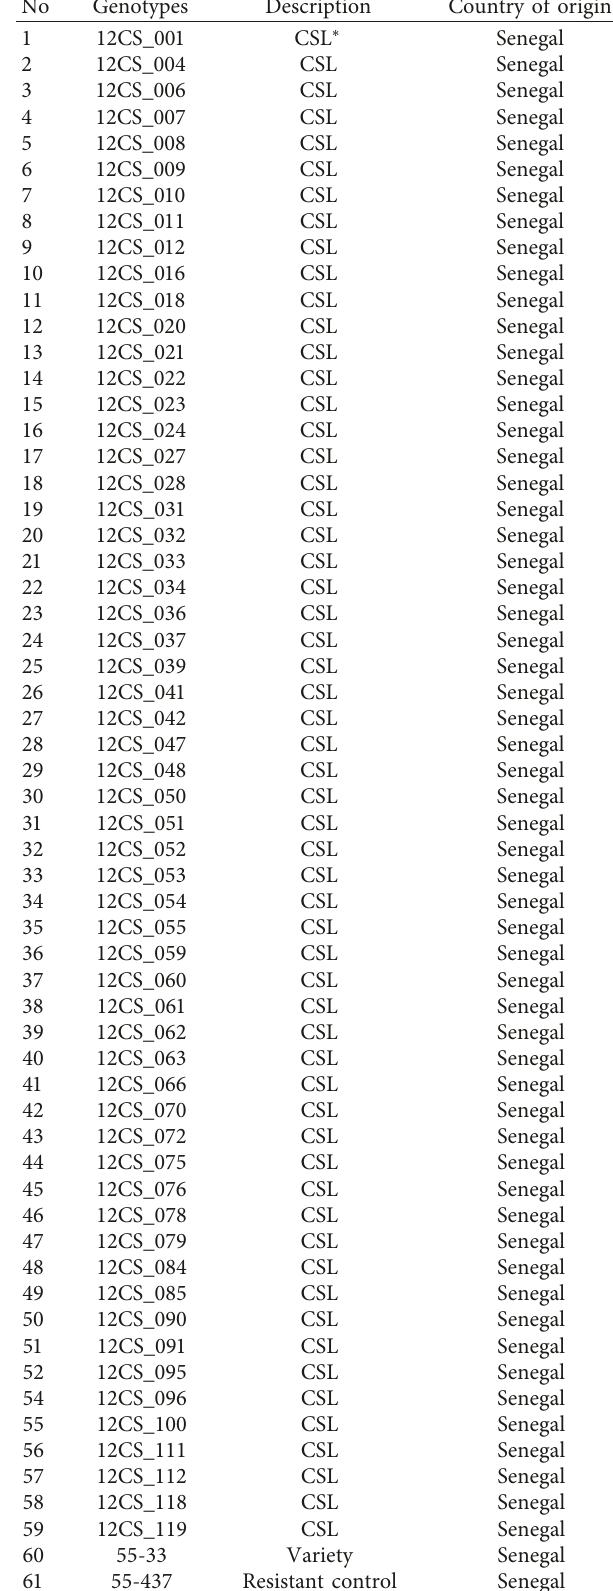
Table 1: Peanut material used in this